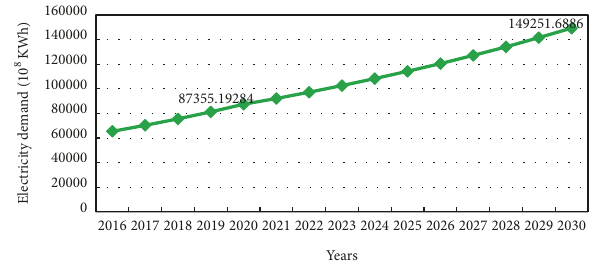
Figure 3: Electricity demand of China from 2016 to 2030.